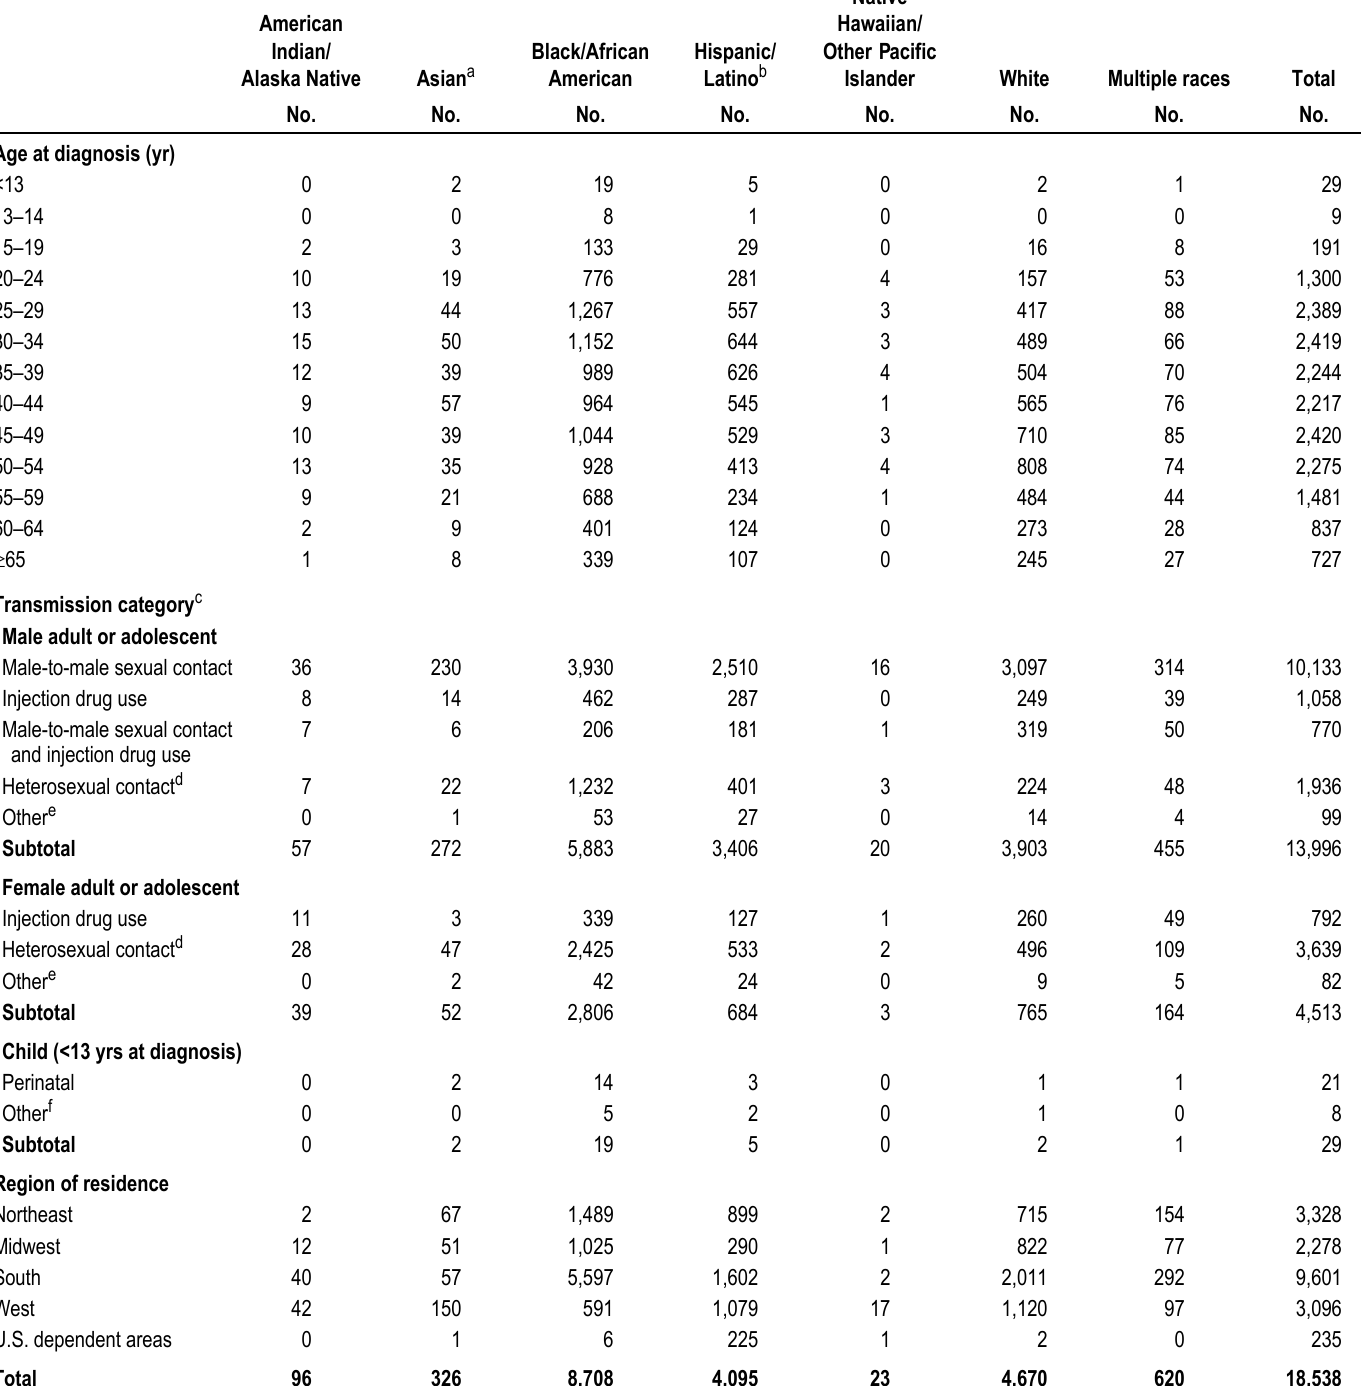
Table 4b. Stage 3 (AIDS), by race/ethnicity and selected characteristics, 2015—United States and 6 dependent